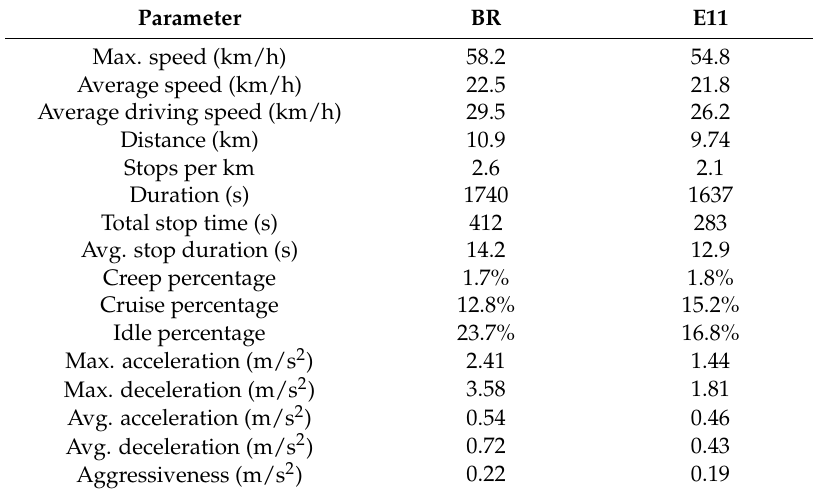
Table 2. Braunschweig (BR) and Espoo 11 (E11) characteristic parameter comparison.